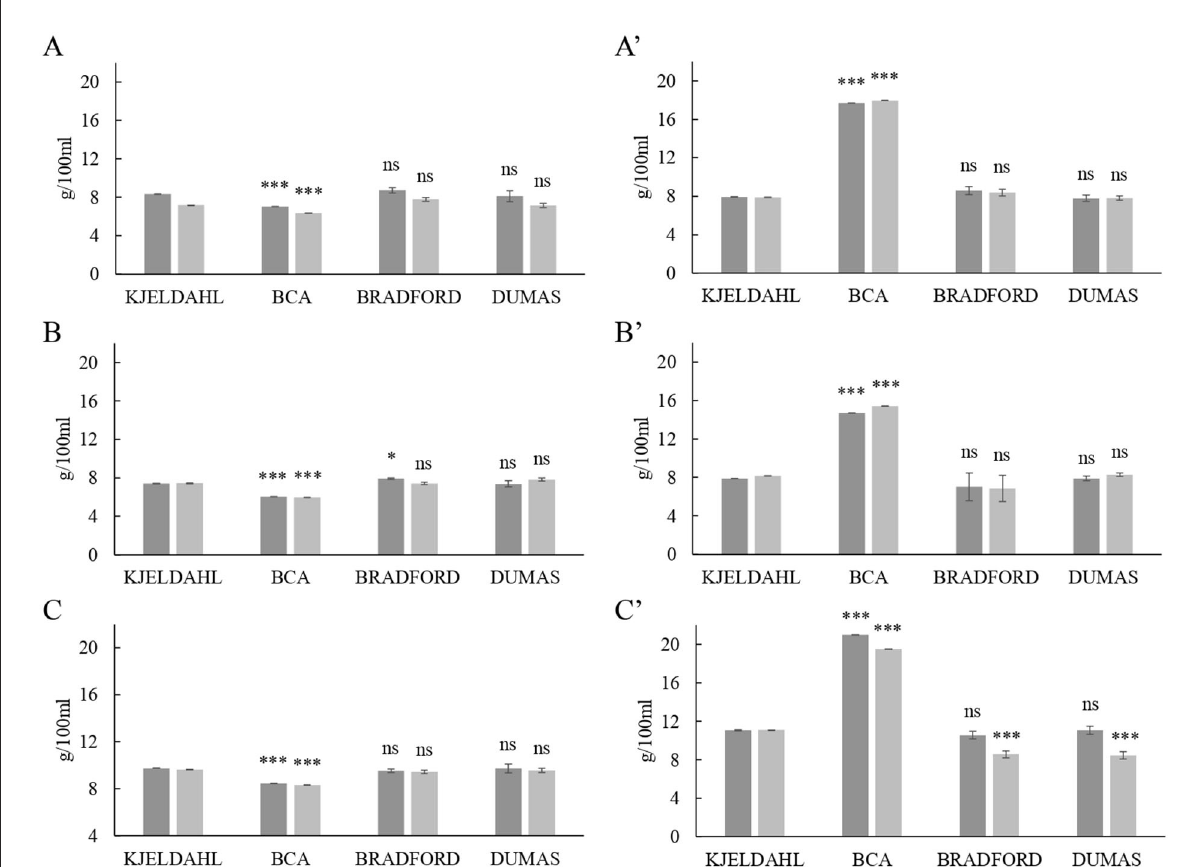
FIGURE3 Comparison of protein levels in milk retentate (g / 100mL) obtained by Kjeldahl official reference method with the contents determined by the bicinchoninic acid assay (BCA), the detergent compatible Bradford assay and the Dumas method. (A) Cow’s skimmed retentate, (A’) cow’s whole retentate, (B) goat’s skimmed retentate, (B’) goat’s whole retentate, (C) sheep’s skimmed retentate, and (C’) sheep’s whole retentate. Different shades of gray indicate different ultrafiltration processes. P –value: *** = P < 0.001; ** = P < 0.01; * = P < 0.05; ns = P >